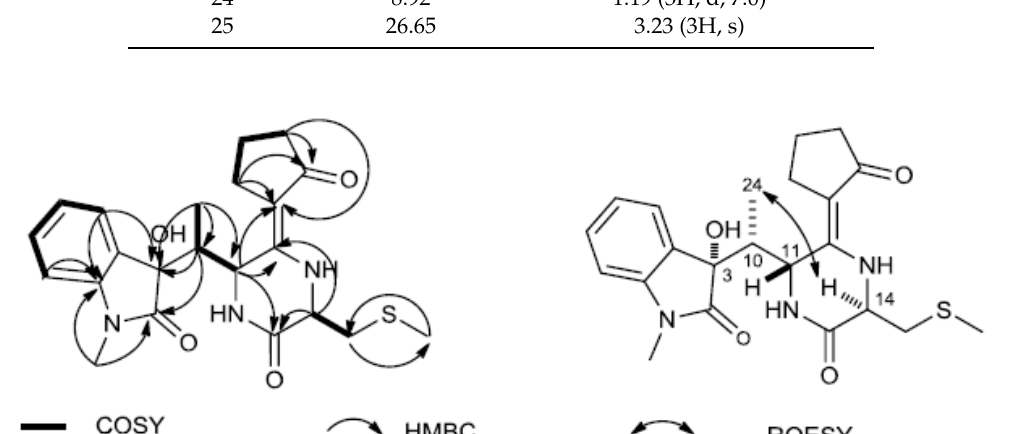
Figure 4. Key 1H–1H COSY, HMBC and ROESY correlations of compound 9 .